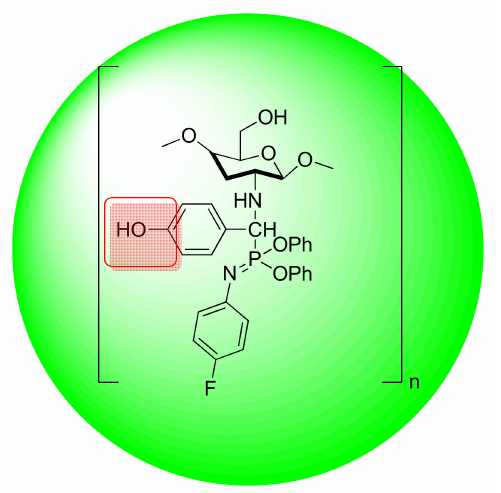
Figure 4. Highly active compound